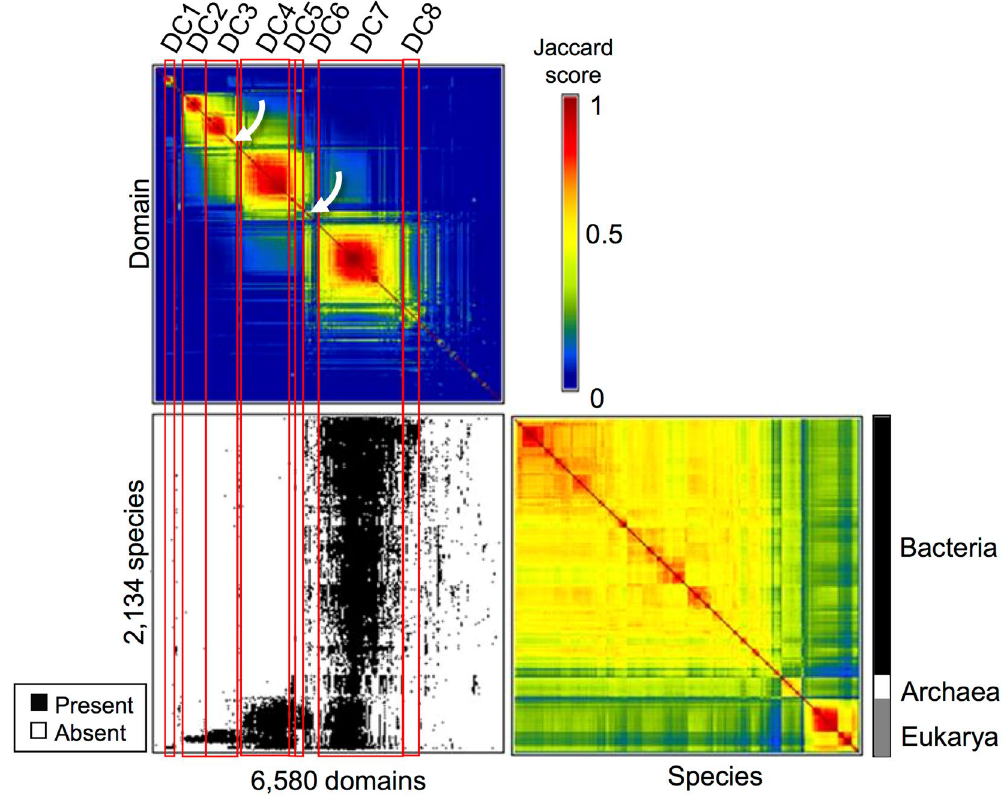
Figure 1. An overview of the GAP results. In this figure, there are three matrices: 1) The species-domain matrix (bottom left); a black dot indicates a domain is present in a species and a white dot that it is absent; 2) the domain-domain matrix (top left); when domains are present in certain species and absent in the rest, these domains will be clustered together, as indicated by warmer colors in the color scheme of the Jaccard similarity score. The 8 major domain clusters found using a Jaccard coefficient cutoff > 0.5 (see Methods) are indicated. The arrows point to a small group of domains mentioned in the Discussion; 3) the species-species matrix (bottom right); when species use domains in a similar way, these species will be clustered together, as indicated by the warmer colors in the color scheme of the Jaccard similarity score (e.g. Eukarya species will be clustered together and not with Bacteria, as the domain present/absent patterns of Eukarya species are different from those of Bacteria).